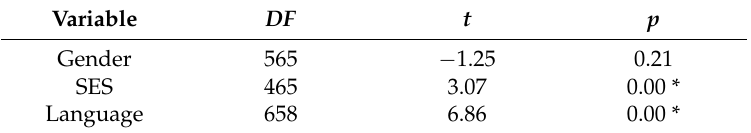
Table 3. Results of the Independent t -test analyses. The effect of noise on gender, SES and language.